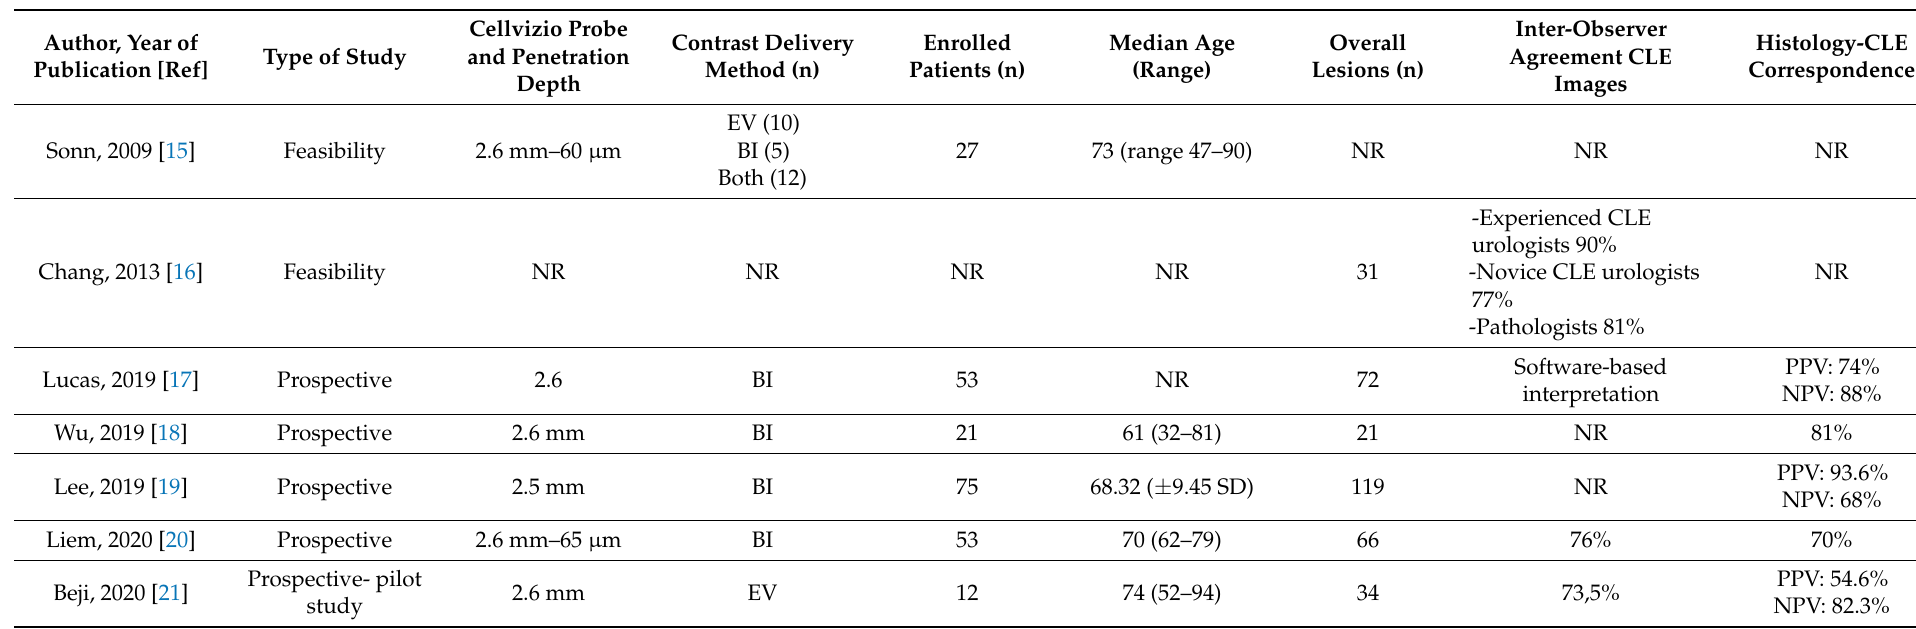
Table 2. Characteristics of included studies. CLE: confocal laser endomicroscopy; EV: intravenous contrast administration; BI: bladder contrast instillation;